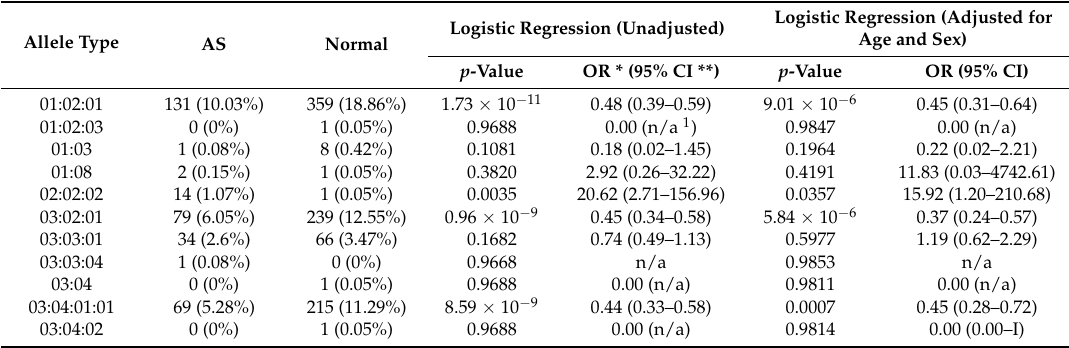
Table 2. Association of the major histocompatibility complex class I molecules (MHC I) HLA-C alleles with Taiwanese